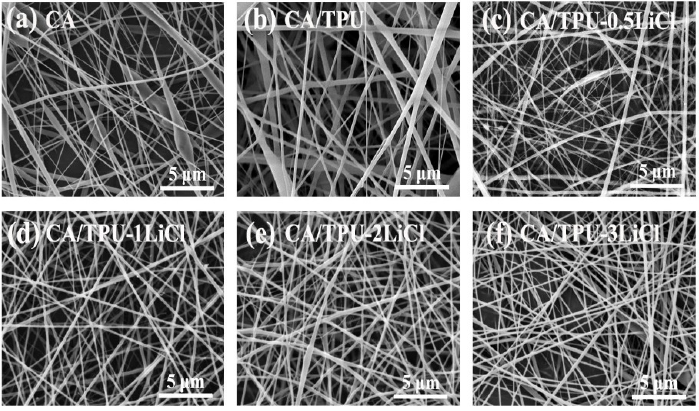
Figure 2. SEM images of ( a ) CA fibers, ( b ) CA/TPU fibers, and CA/TPU ‐ xLiCl fibers prepared by coaxial spinning with different LiCl concentrations: ( c ) 0.5 wt%, ( d ) 1 wt%, ( e ) 2 wt% and ( f ) 3 wt%.